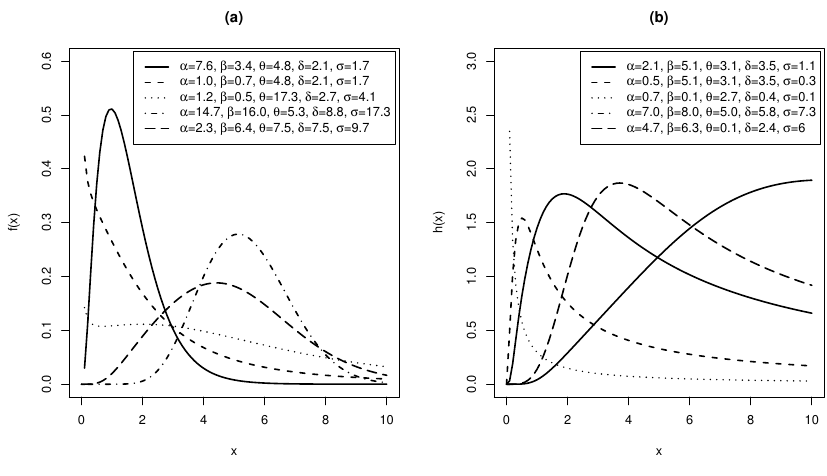
Figure 2 – Plot of the density and hazard functions of EOLxLx for some possible parameter